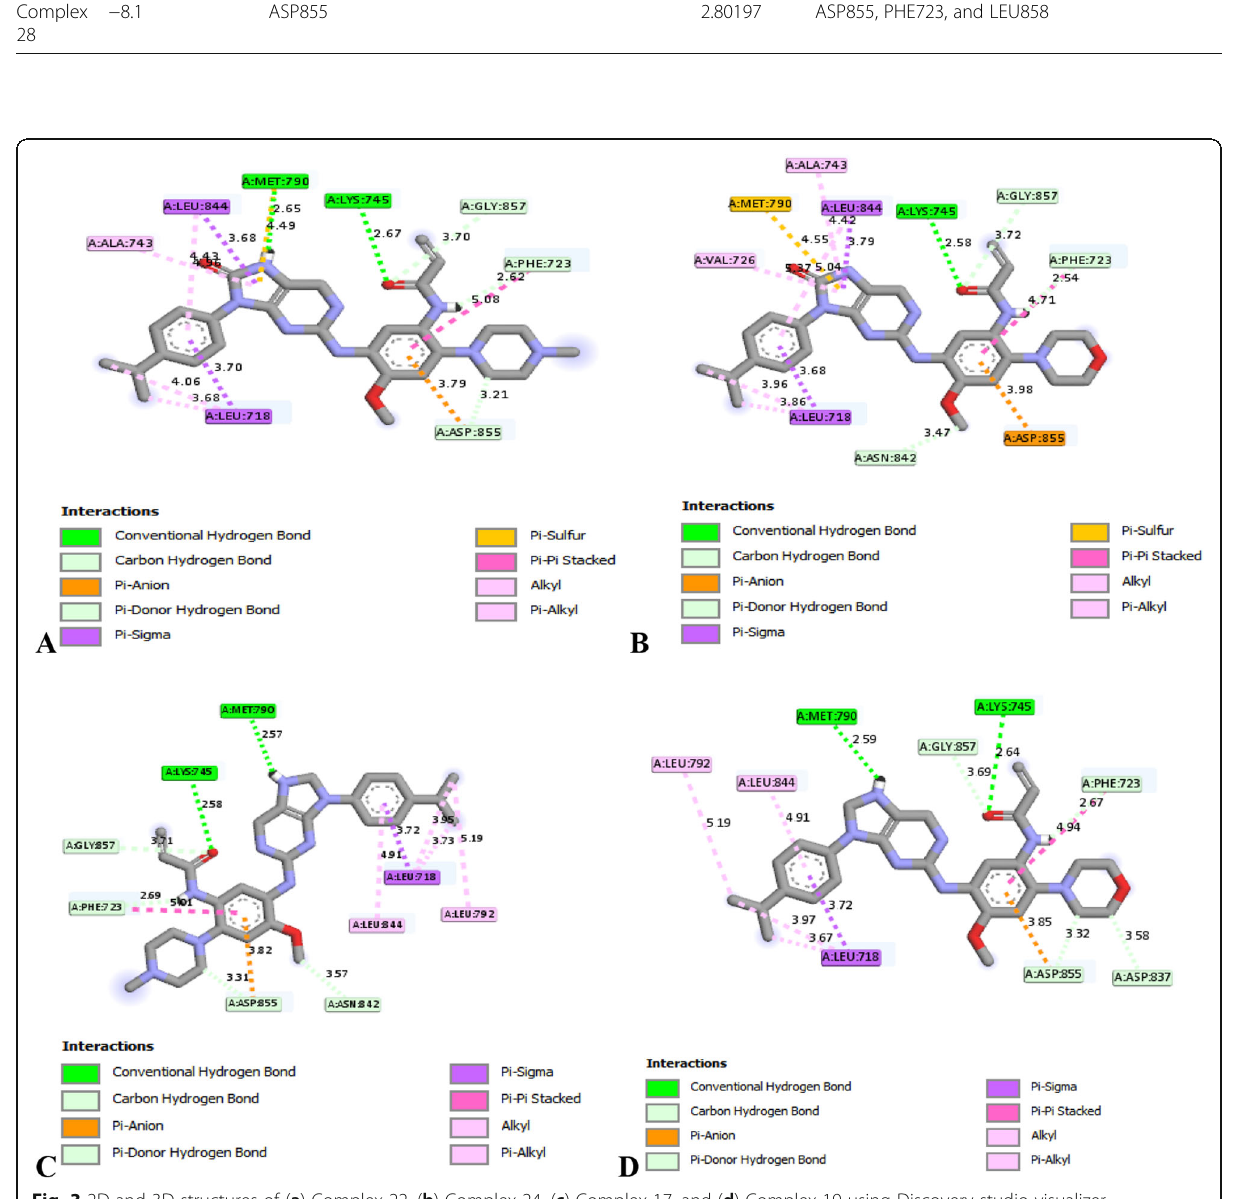
Fig. 3 2D and 3D structures of ( a ) Complex 22, ( b ) Complex 24, ( c ) Complex 17, and ( d ) Complex 19 using Discovery studio